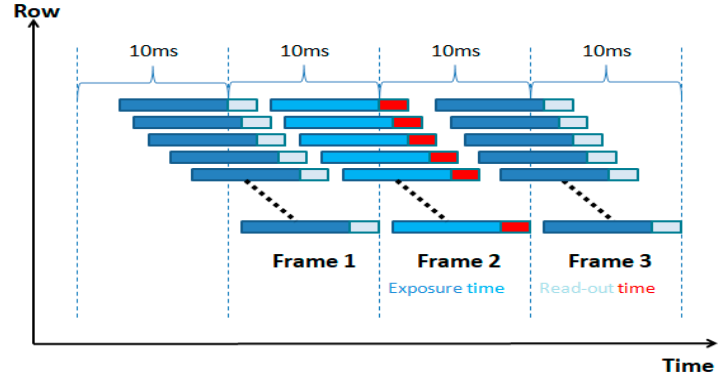
Figure 1. The working principle of the rolling shutter mechanism.